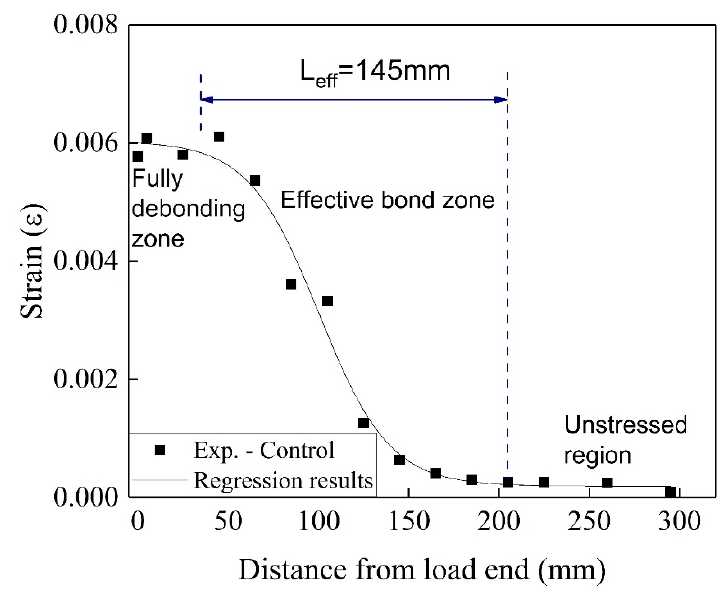
ff ective bond length for the reference Figure 7. Effective bond length for the reference specimen. Figure 7. E